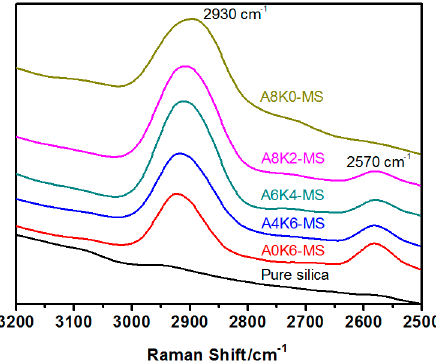
Figure 3. Raman spectra of pure silica and all modified silica.